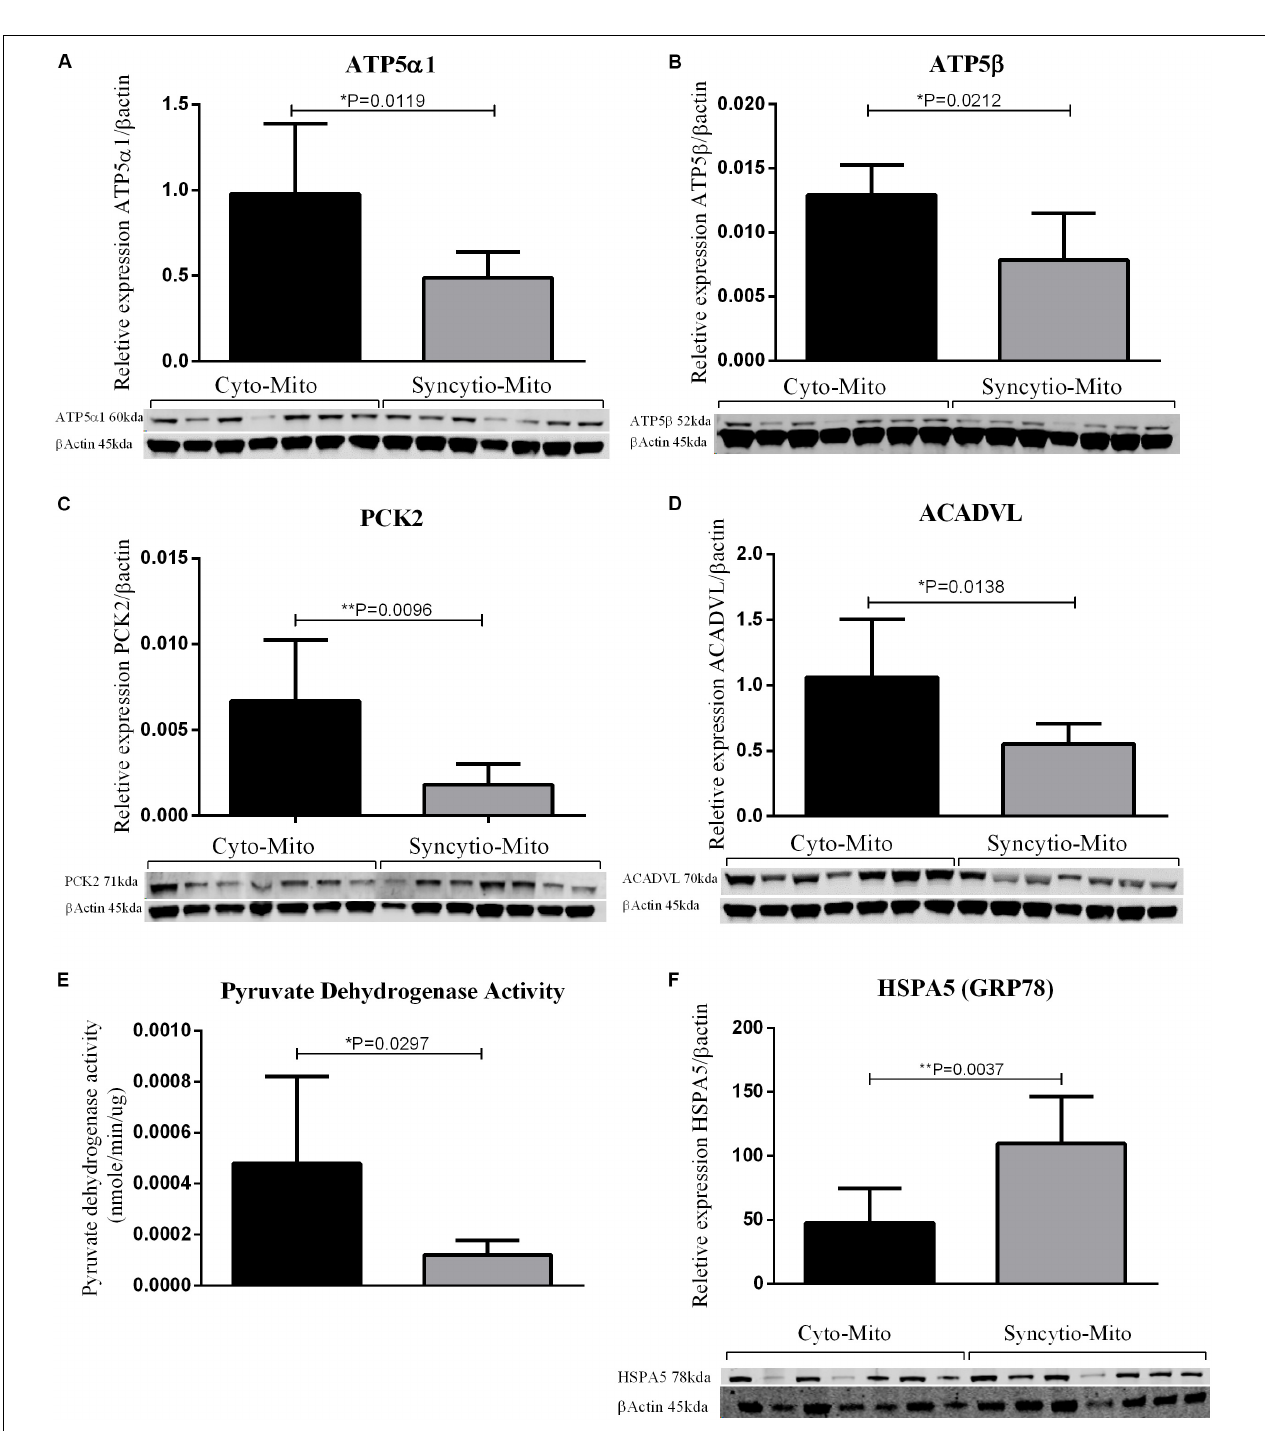
FIGURE 1 | Western blots and densitometry relative to β -actin of Cyto-Mito and Syncytio-Mito for ATP5 α 1 (A) , ATP5 β (B) , PEPCK2 (C) , and ACADVL (D) . Pyruvate dehydrogenase activity (E) was assessed by activity assay and expressed as nmole/min/ µ g of protein. Western blots and densitometry relative to β -actin for HSPA5 (F) Cyto-Mito (Black), Syncytio-Mito (gray). Mean ± SD, n = 7.